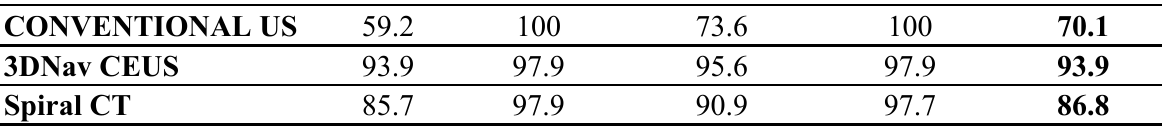
Table 2. Sensitivity, specificity, diagnostic accuracy, positive and negative predictive values of conventional US, 3-D NAV CEUS and spiral